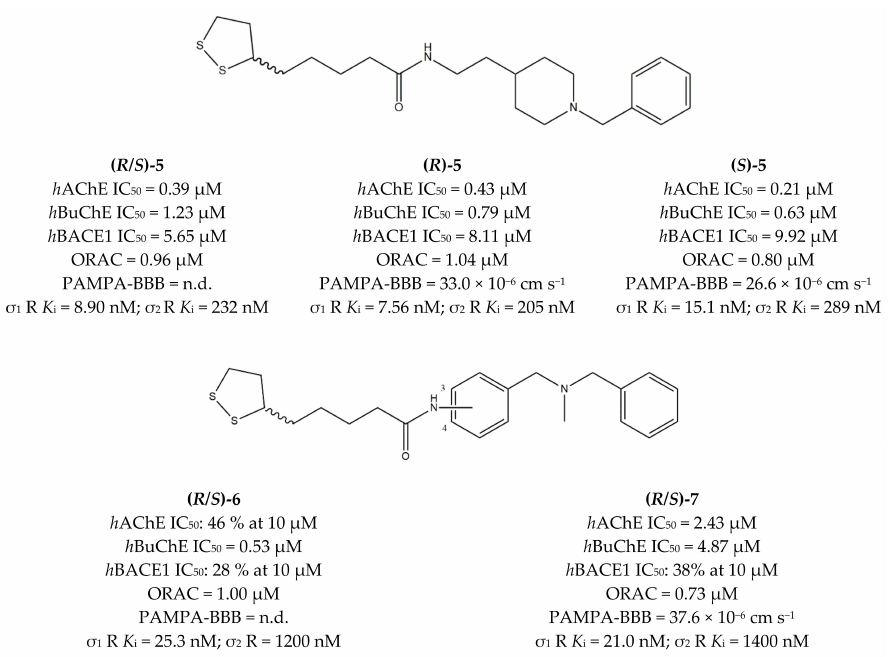
Figure 5. Compounds ( 5 , 6 ) and ( 7 ) structures and pharmacological profile for σ receptor ( σ 1 R and σ 2 R), human acetylcholinesterase ( h AChE), human butyrylcholinesterase ( h BuChE), (BACE1), Oxygen Radical Absorbance Capacity (ORAC) and parallel artificial membrane assays (PAMPA-BBB)